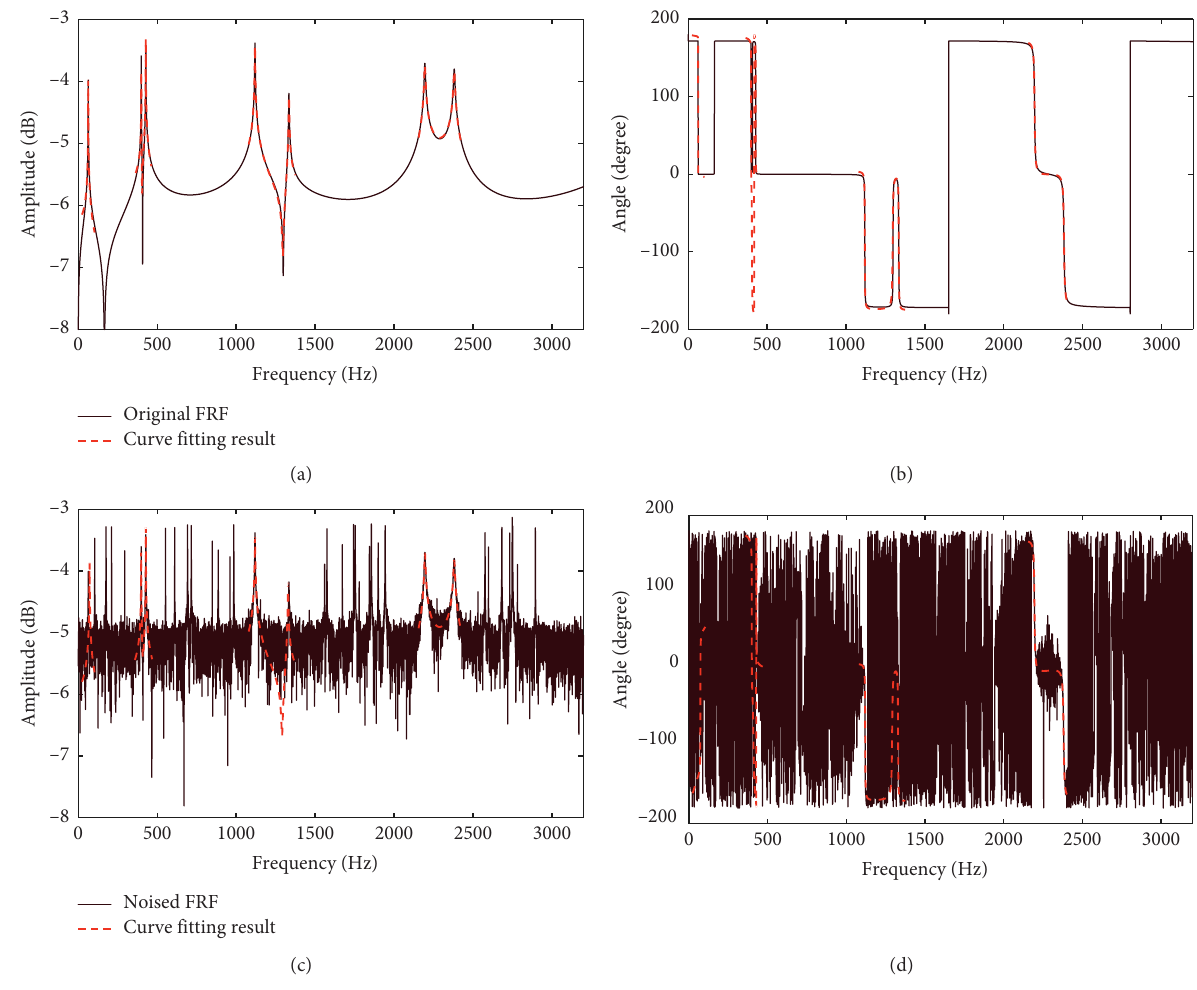
Figure 4: Curve fitting results of the noised and noise-free FRF signals. (a) Curve fitted energy spectrum of original FRF. (b) Curve fitted Table 1: Modal parameters of the noised FRF